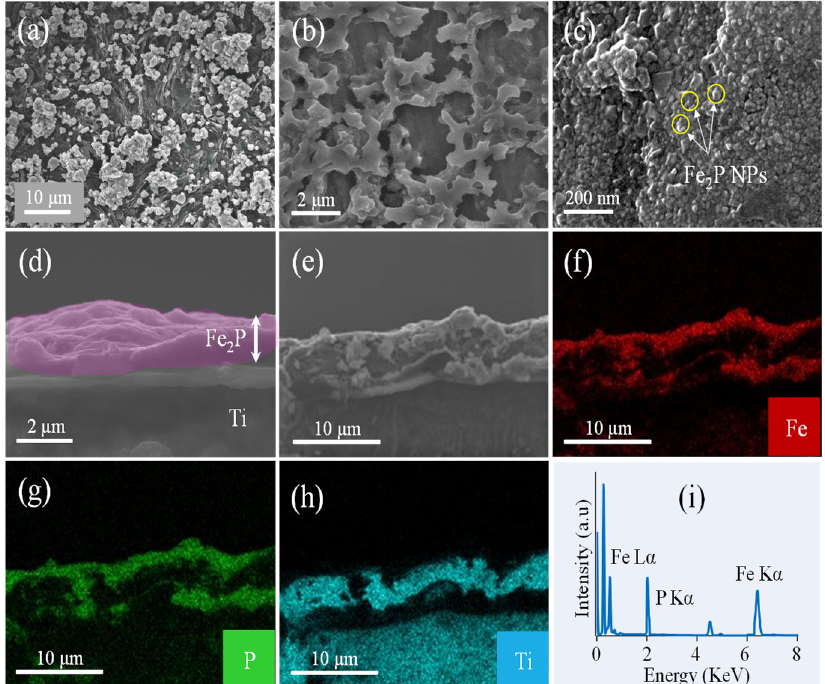
Figure 2. SEM images of Fe 2 P thin film at different magnifications in ( a – c ) top views and in ( d ) cross-sectional view. ( f – h ) Images with elemental maps are given for Fe, P and Ti, taken from the Fe 2 P sample shown in ( e ). ( i ) EDS spectrum recorded from the image in ( e ).